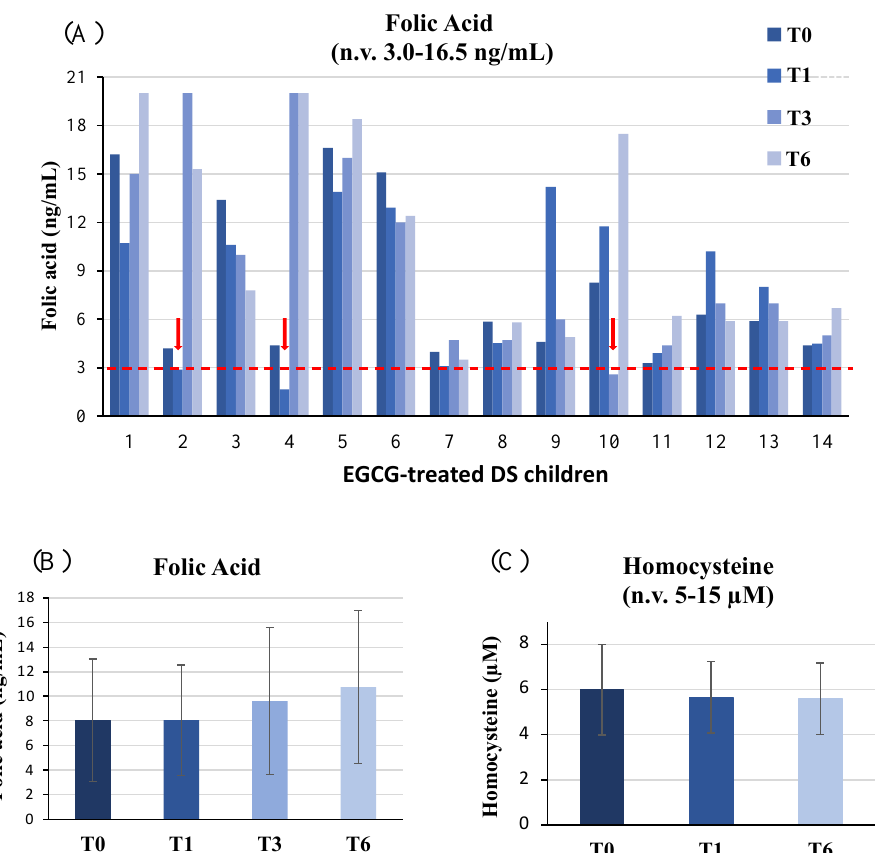
Figure 1. Plasma folate and homocysteine levels. Folate levels analyzed in EGCG-treated DS children ( A ) and the mean values of plasma folic acid ( B ) and homocysteine ( C ) levels are depicted. In panels 1B and 1C, mean values at individual time-points are not significantly different ( p > 0.05) compared to baseline (T0).